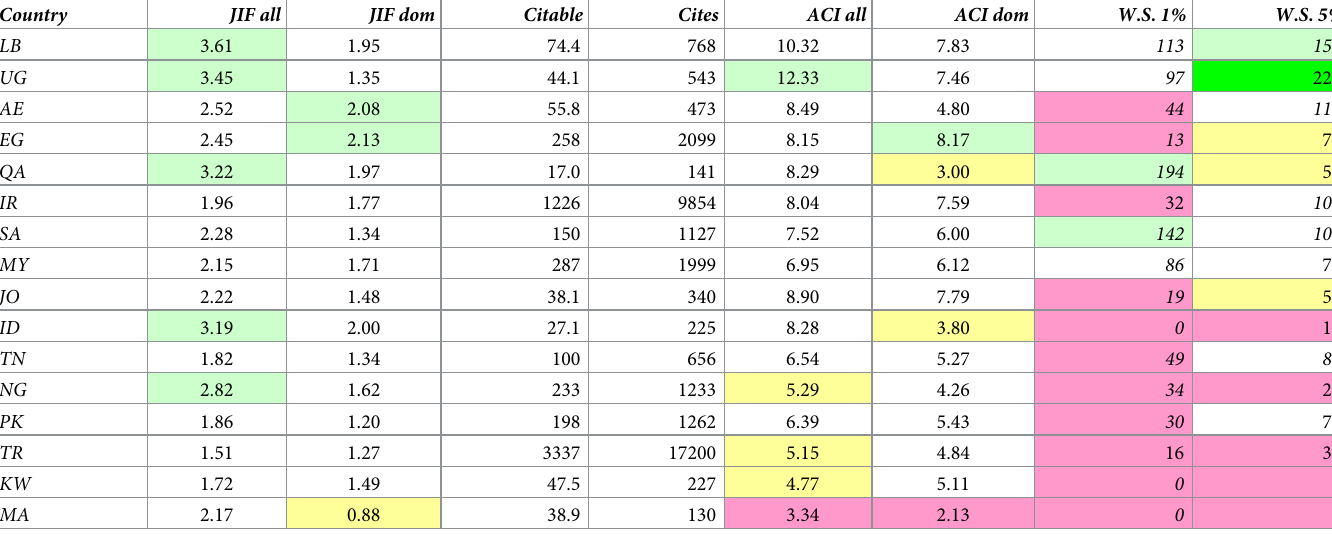
Table 8. Journal Impact Factors for all and domestic mental health disorders research papers from 16 leading OIC countries; also citation performance (five-year counts, fractional country counts) (ACI all and ACI dom), and presence in the top 1% and 5% (59, 26 cites or more) showing World-Scale (W.S.) values (relative to norm of 100).